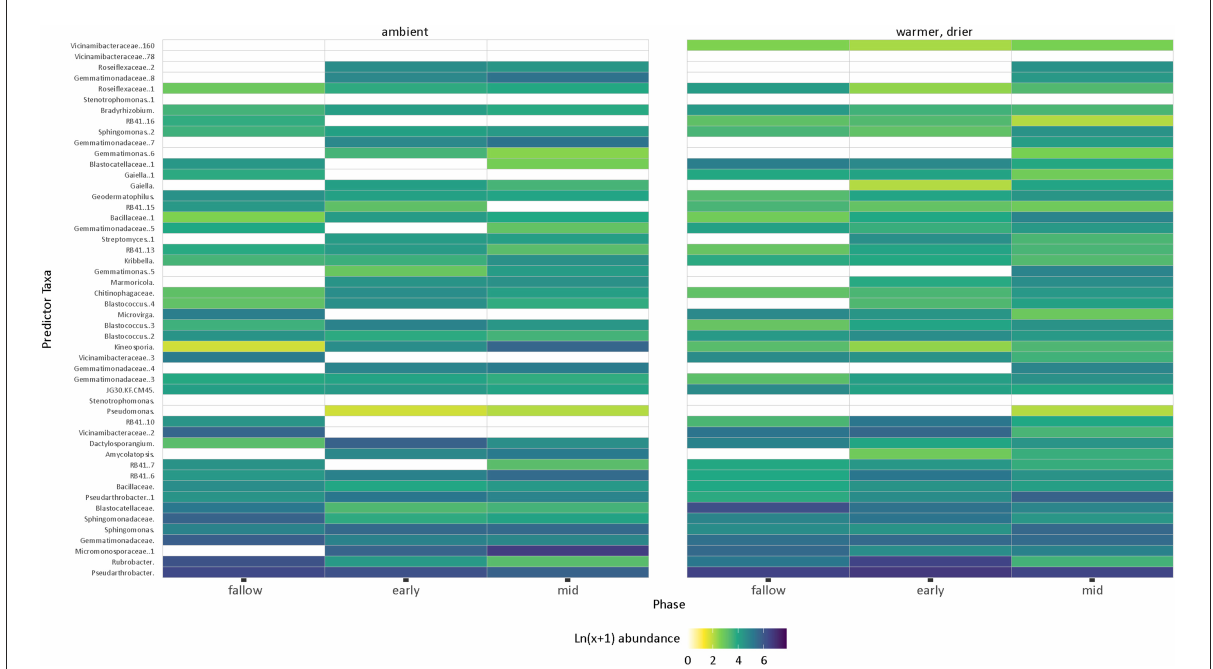
FIGURE7 Random forest analysis of the 2018 samples showing the natural log(x + 1) abundance of the top 50 predictor sequence variants under ambient and warmer/drier conditions. White spaces indicate taxa that are absent or at very low abundance. Sequence variants from unspecified genera are identified at the family